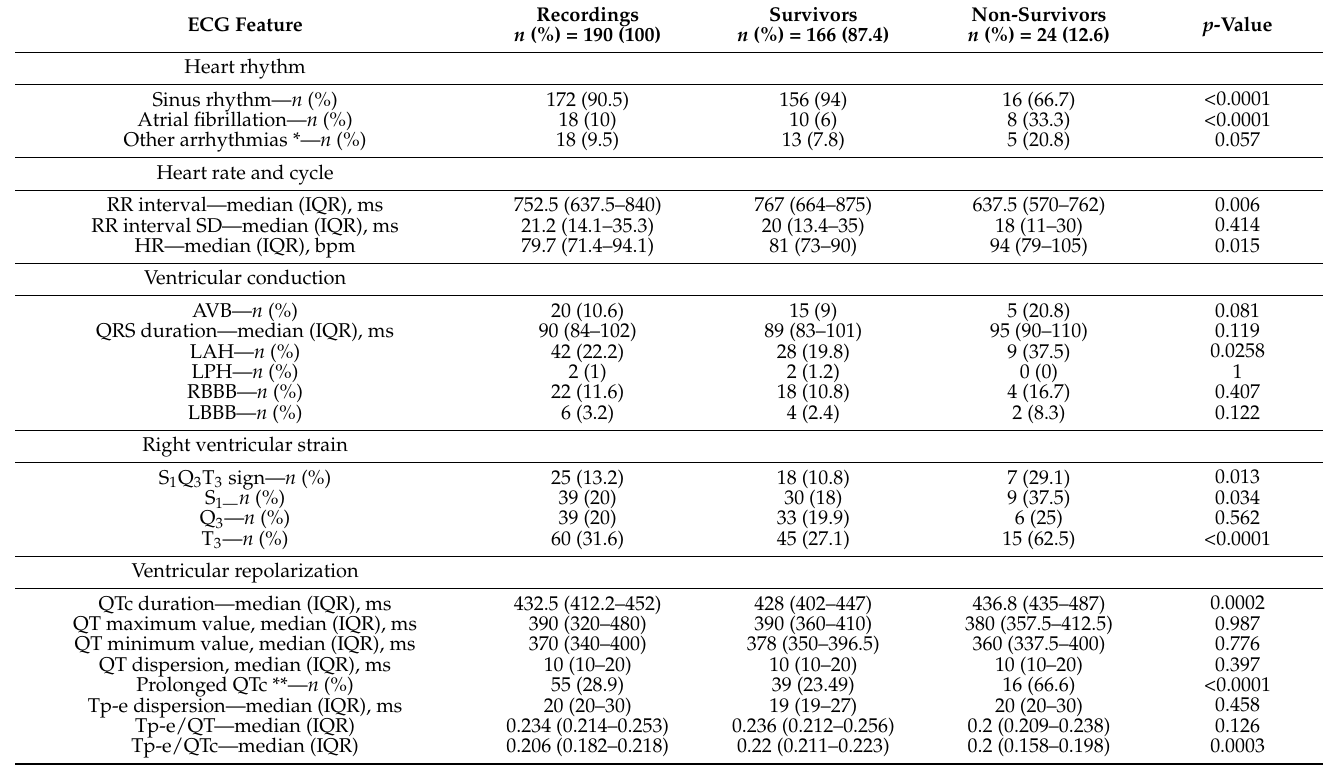
Table 2. Electrocardiography features at Emergency Department admission.